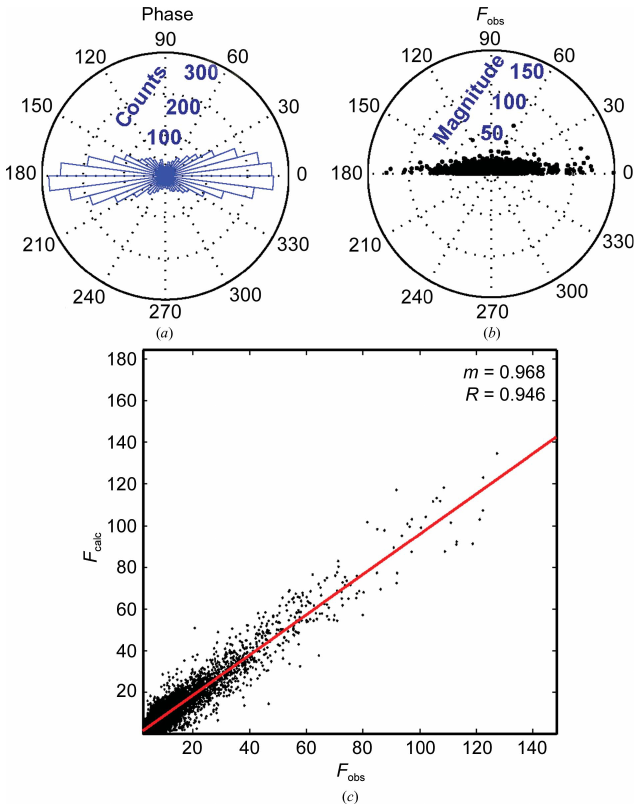
Figure 3 ( a ) The calculated phase associated with each reflection in the P 1 refinement of racemic GSTSTA data obtained by MicroED was analyzed and plotted as a histogram along the unit circle. ( b ) The magnitude of each reflection is plotted as a function of the absolute value of its associated phase. ( c ) A plot of F o versus F c values for each reflection in this data set shows a distribution that can be fitted by linear regression, shown as a red line, with slope m = 0.97 and R value